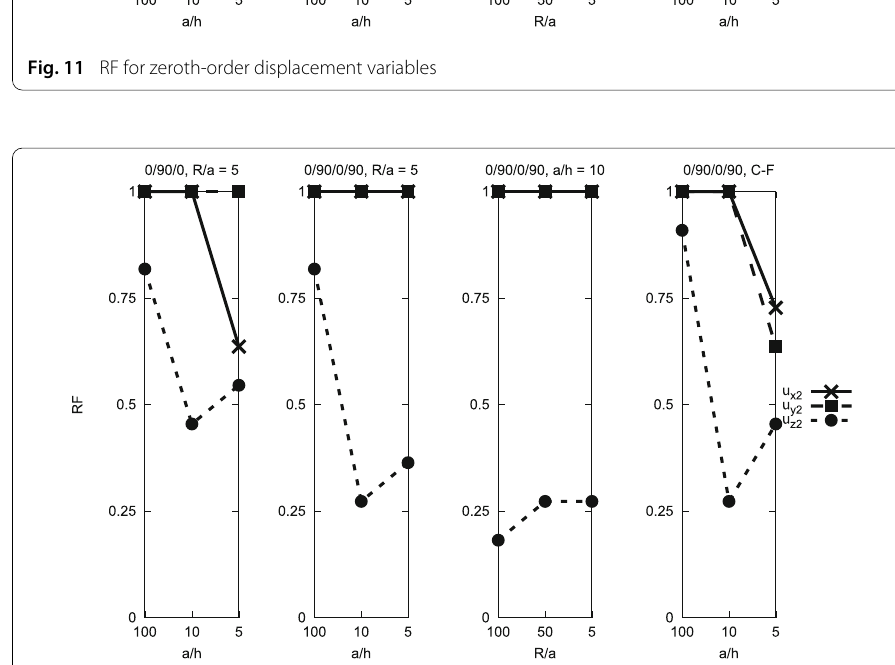
Fig. 12 RF for first-order displacement variables